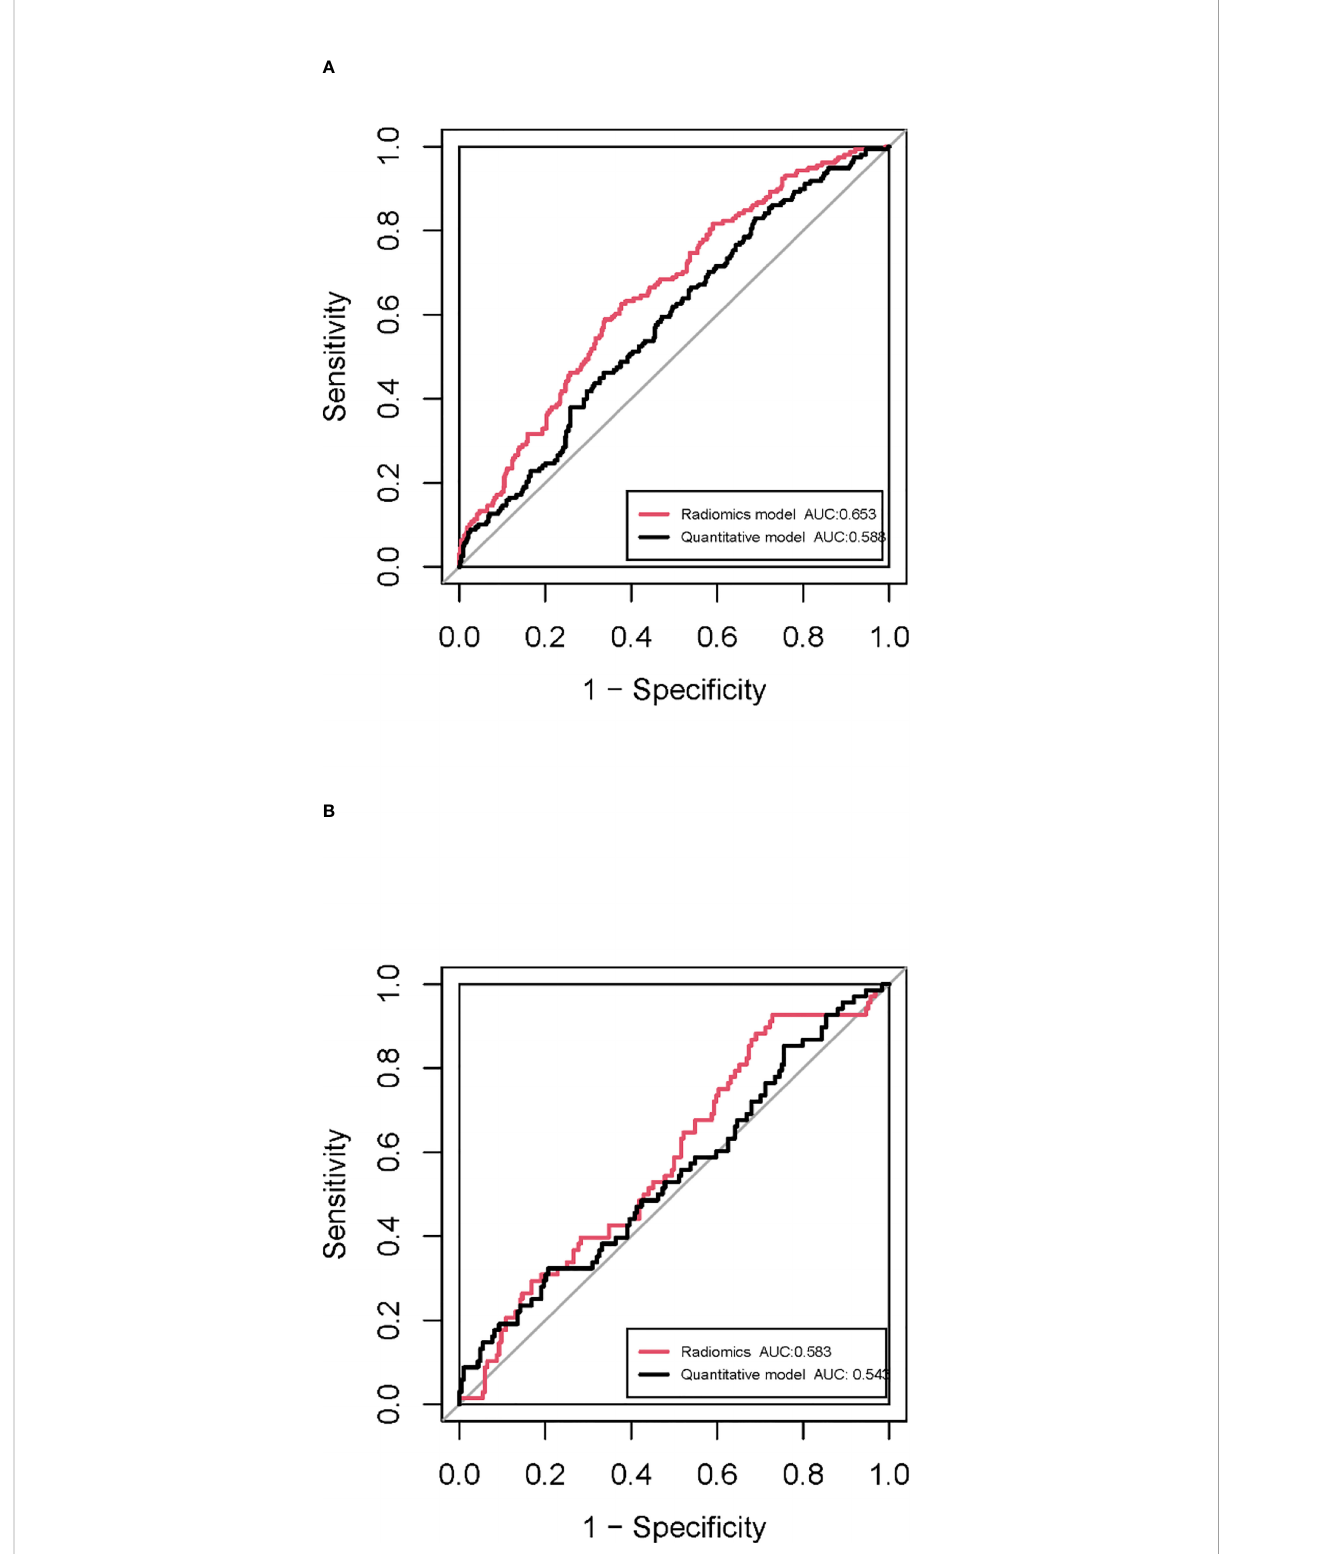
FIGURE 5 ROC curves of the radiomic model and quantitative model in the training cohort (A) and the test cohort (B)